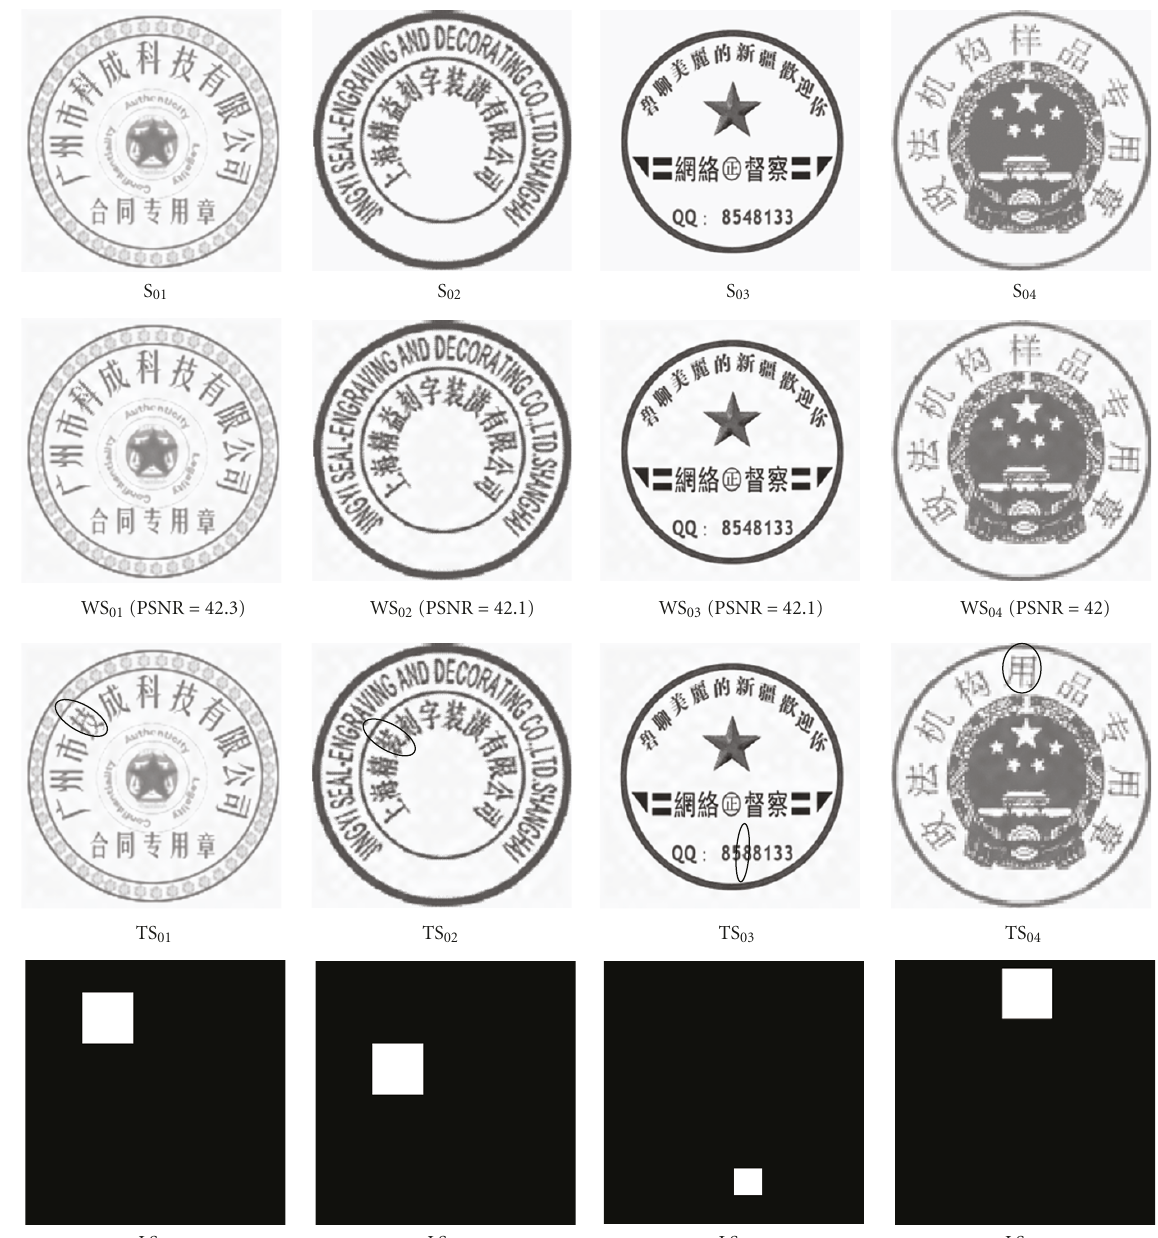
Figure 12: Authentication results when some Chinese digital seal images are maliciously manipulated where S: original seal image, WS: watermarked seal image, TS: tampered watermarked seal image and the oval highlights the tampered part, LS: location of the attacked